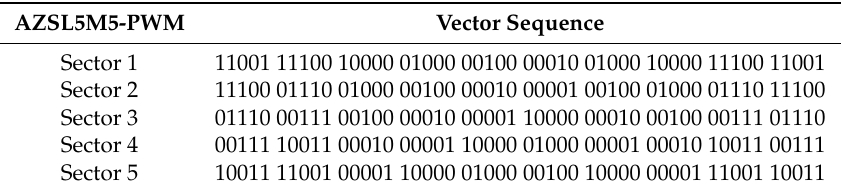
Table 4. AZSL5M5-PWM vector sequences (odd vectors).